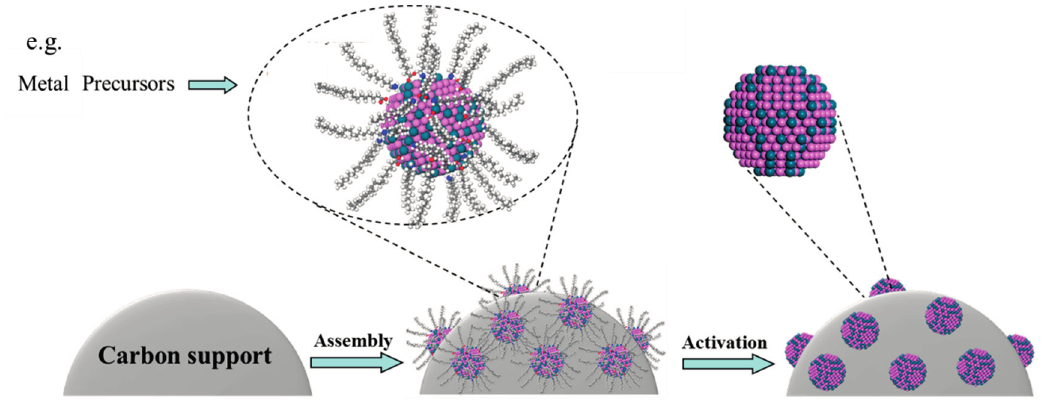
Figure 1. Illustration of the synthesis, assembly, and activation of nanoalloy particles for the preparation of the supported